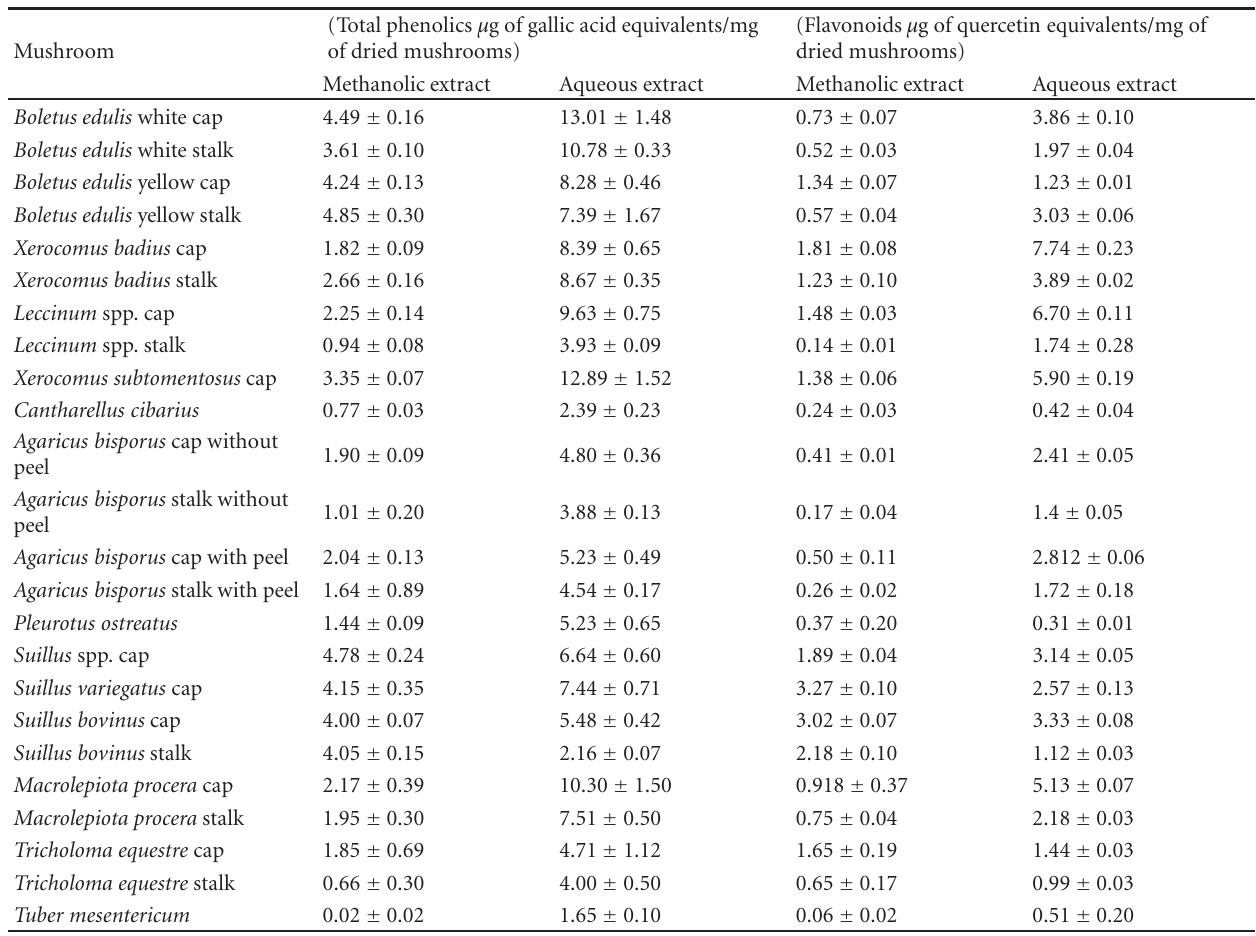
Table 1: The content oftotal phenolics( μ g of gallic acid equivalents/mg of dried mushrooms)and flavonoids( μ g of quercetin equivalents/mg of dried mushrooms) of edible Polish